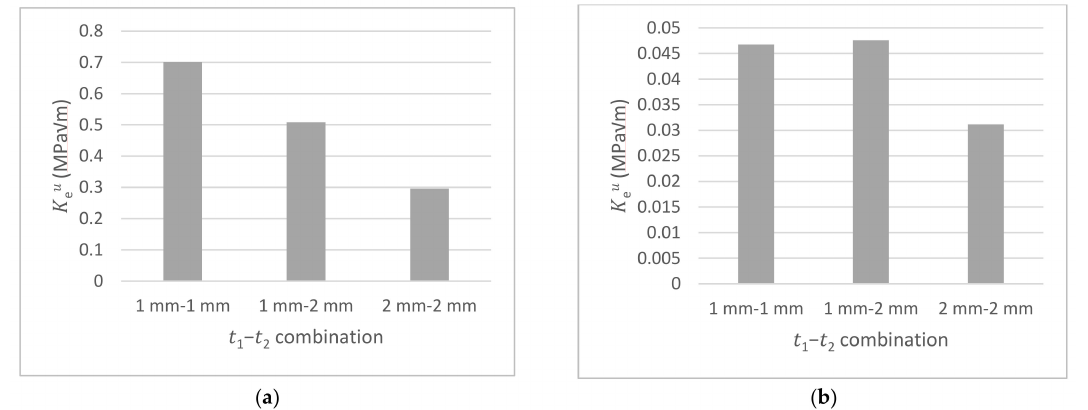
Figure 12. The comparison of SIF values over different specimen types and thickness combinations. ( a ) Coach–peel. ( b ) Lap–shear.